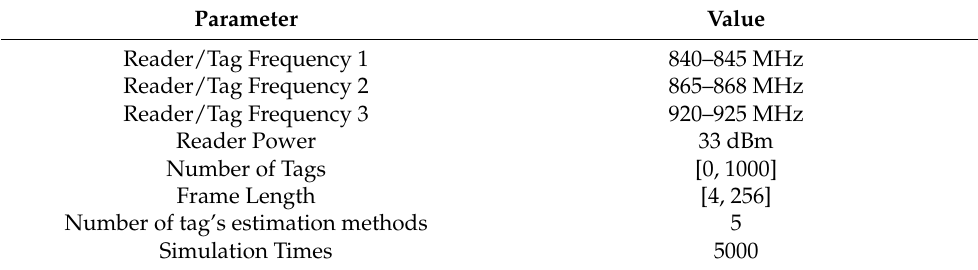
Table 3. Simulation parameters.